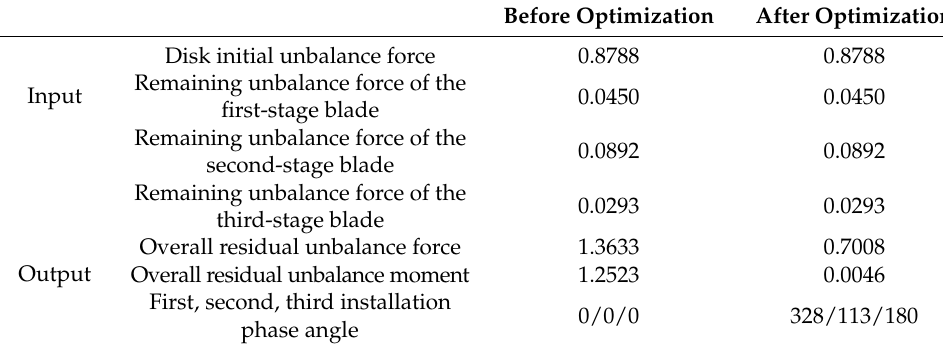
Table 6. Comparison of results before and after